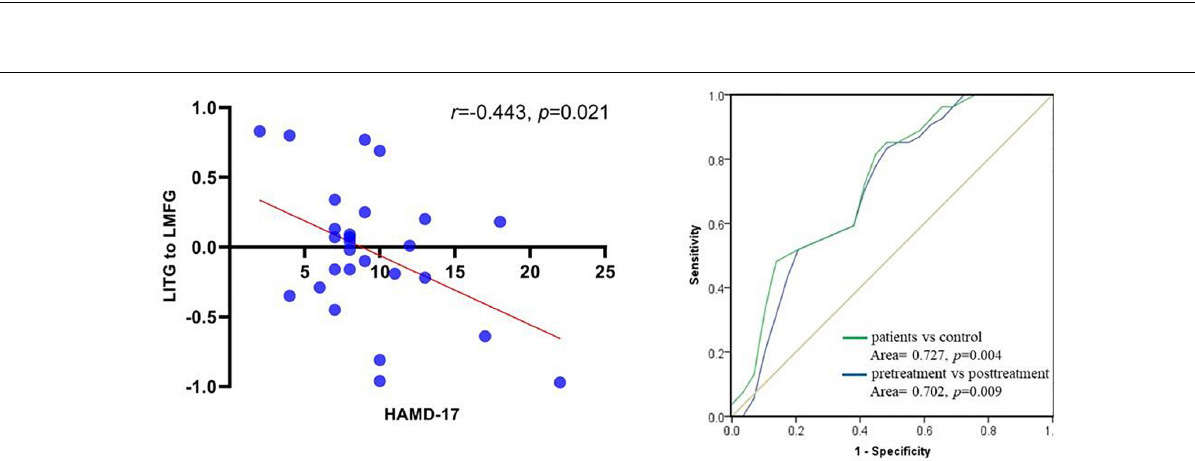
FIGURE 4 | Granger causality analysis pre- and post- rTMS in MDD. (A) Brain regions showing group differences in causal connectivity from the seed point (LMFG) to whole brain in pre- and post-rTMS comparison; (B) Brain regions showing group differences in causal connectivity from the whole brain to seed point (LMFG) in pre- and post-rTMS comparison. Red areas show brain regions where post- rTMS patients with MDD had increased causal connectivity than pre- rTMS; Blue areas show brain regions where post- rTMS patients with MDD had decreased causal connectivity than pre-rTMS. The color bar represents t -values.